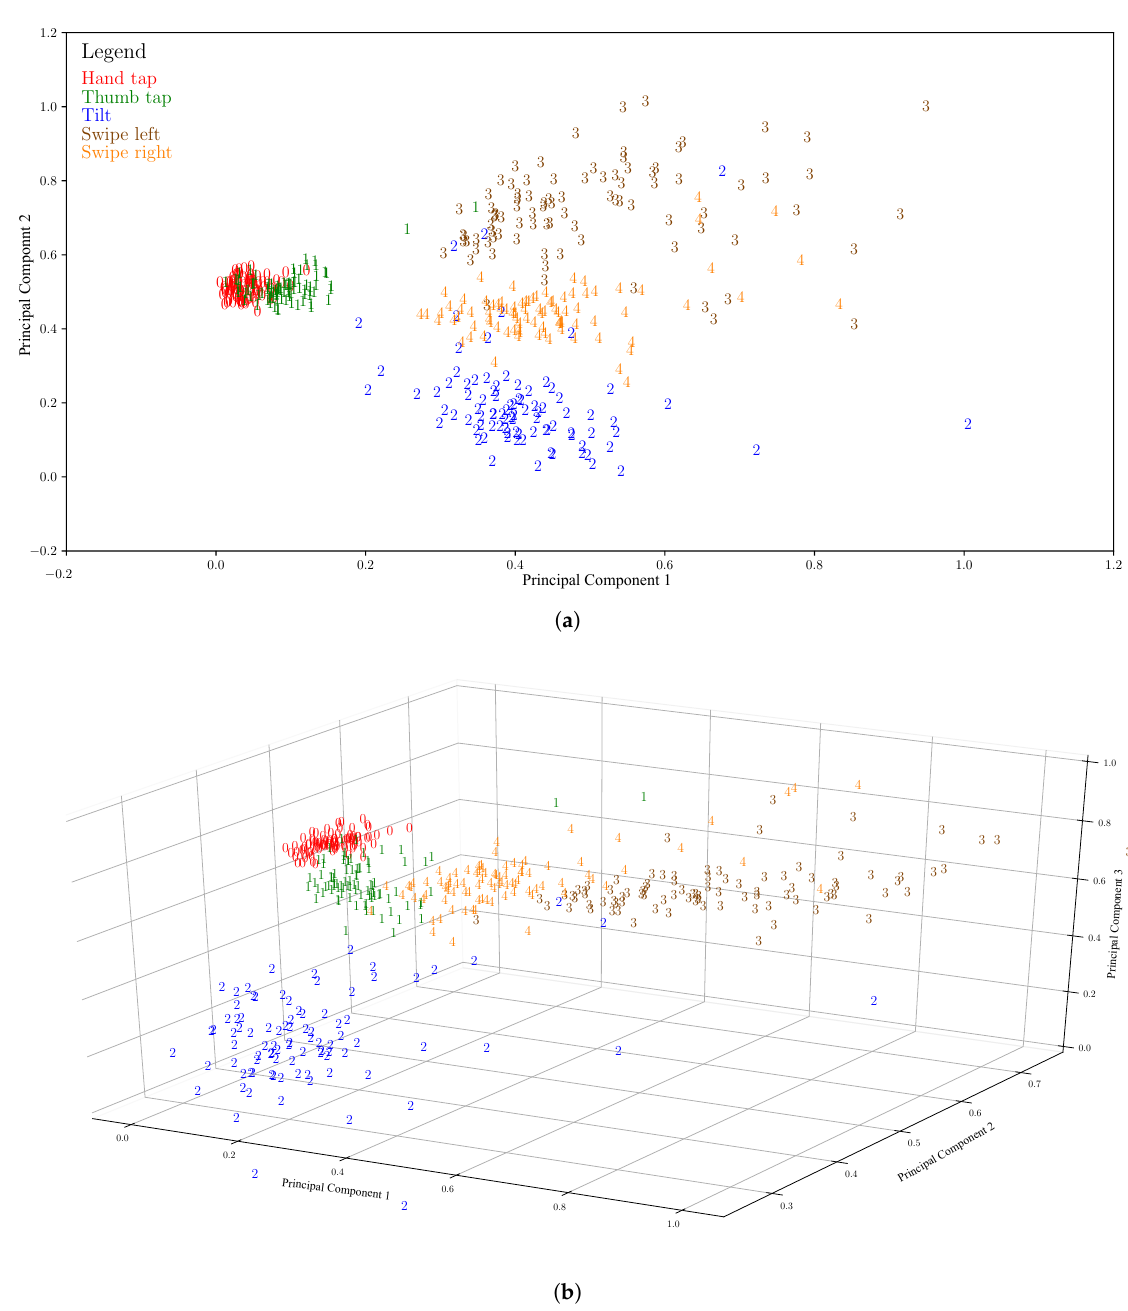
Figure 5. PCA’s linear projection of the dataset in two-dimensions ( a ) and three-dimensions ( b